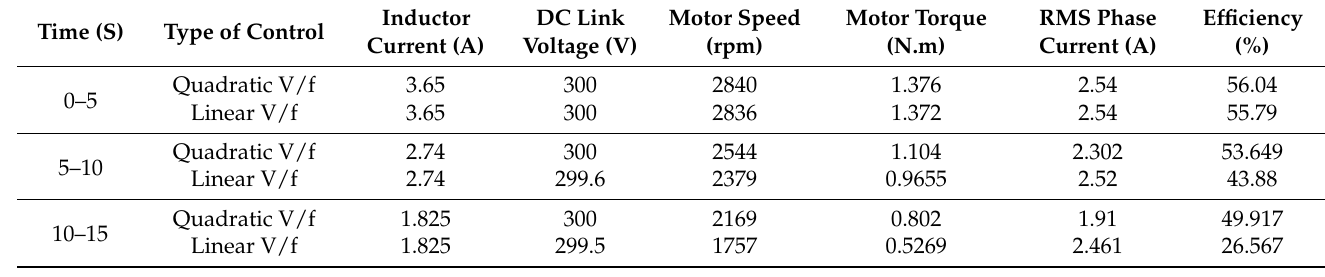
Table 4. Simulation results for both Q V/f and L V/f.